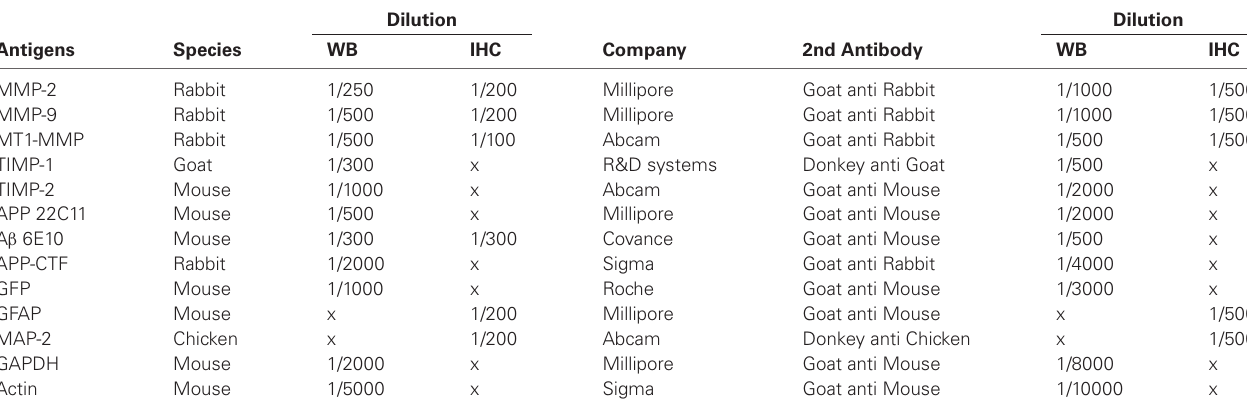
Table 2 | Detail of primary and secondary antibodies used for western blot and immunohistochemistry in this study . Dilution